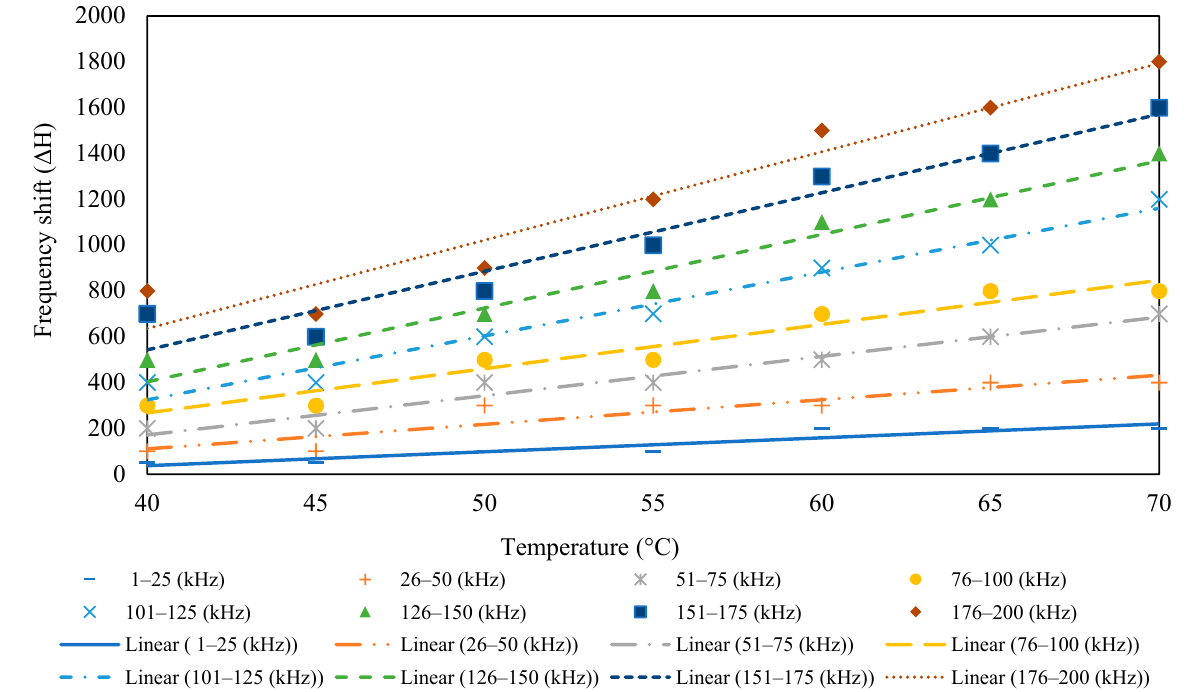
Figure 4. RMSD index at different temperature.